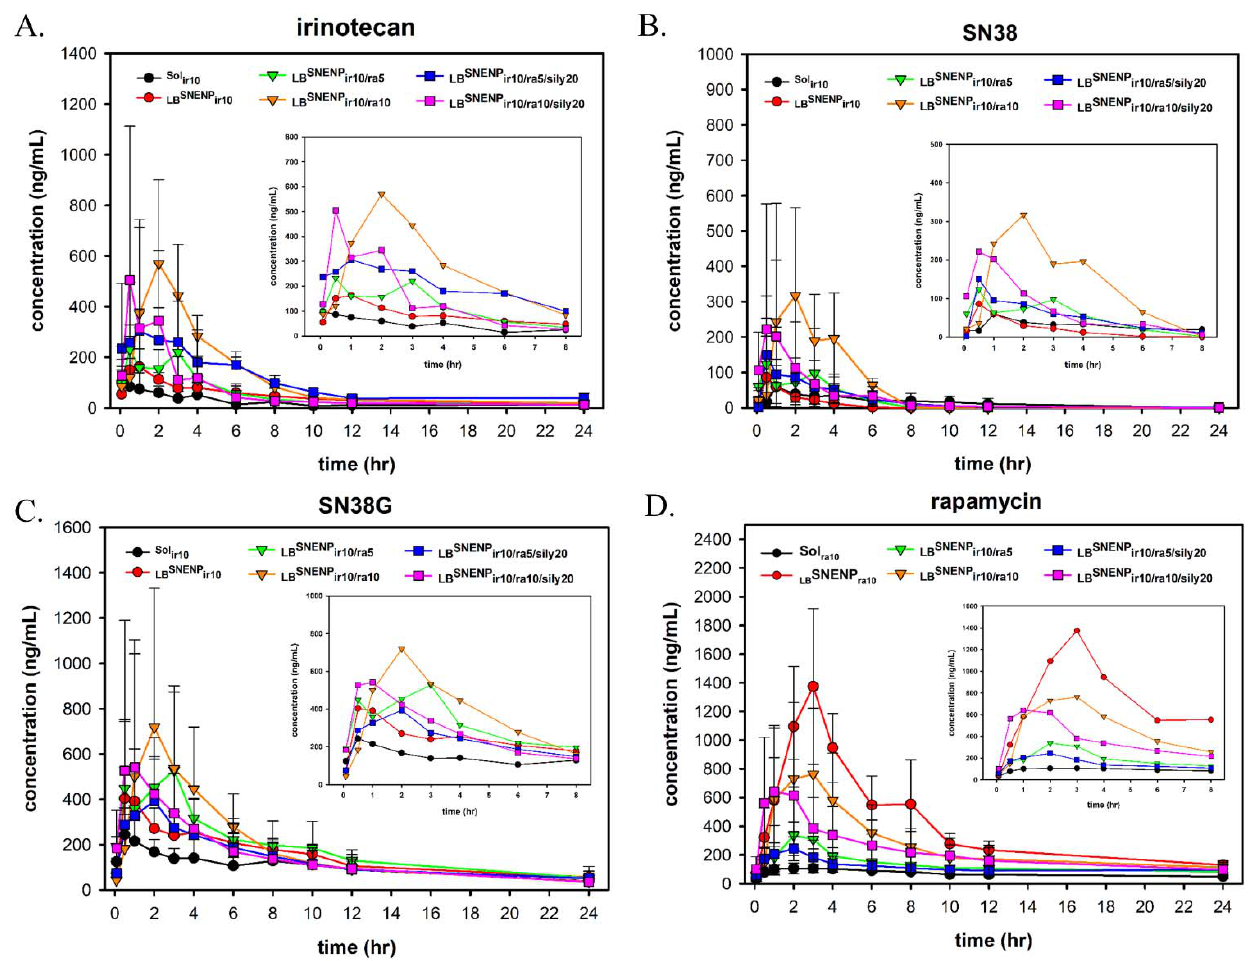
Figure 2. In vivo PK profiles of irinotecan ( A ), SN38 ( B ), SN38G ( C ), and rapamycin ( D ) after oral administration with Sol ir10 , Sol ra10 , LB SNENP ir10 , LB SNENP ra10 , LB SNENP ir10/ra5 , LB SNENP ir10/ra10 , LB SNENP ir10/ra5/sily20 , and LB SNENP ir10/ra10/sily20 . Each point is shown as mean ± standard deviation (n = 3–5). Abbreviations: Sol, solution; LB SNENP, lecithin-based self-nanoemulsifying nanoemulsion preconcentrate; ir, irinotecan; ra, rapamycin; sily, silymarin; number is dose. Table 7. PK parameter estimations of irinotecan after oral administration with Sol ir10 , LB SNENP ir10 ,